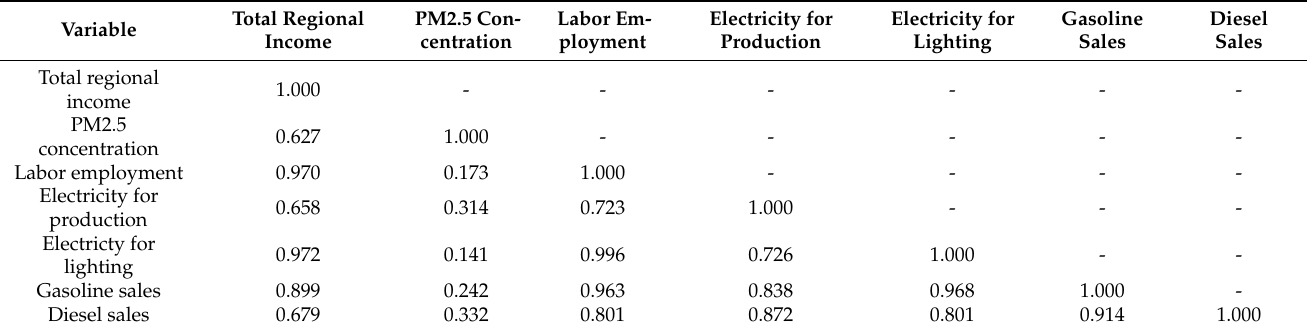
Table 2. Correlation matrix of input/output variables.